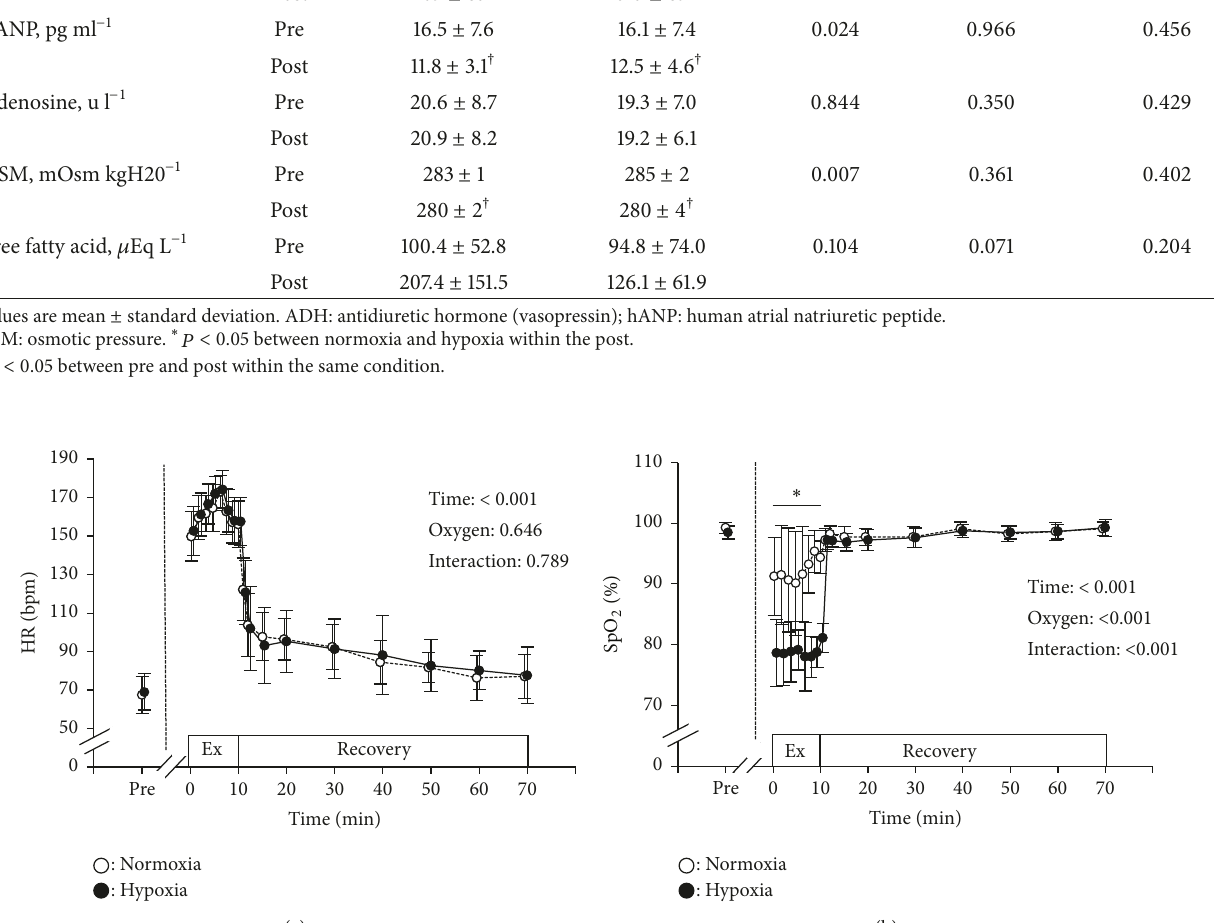
increased fourfold over the pre-exercise values; thereafter, both parameters decreased in accordance with time